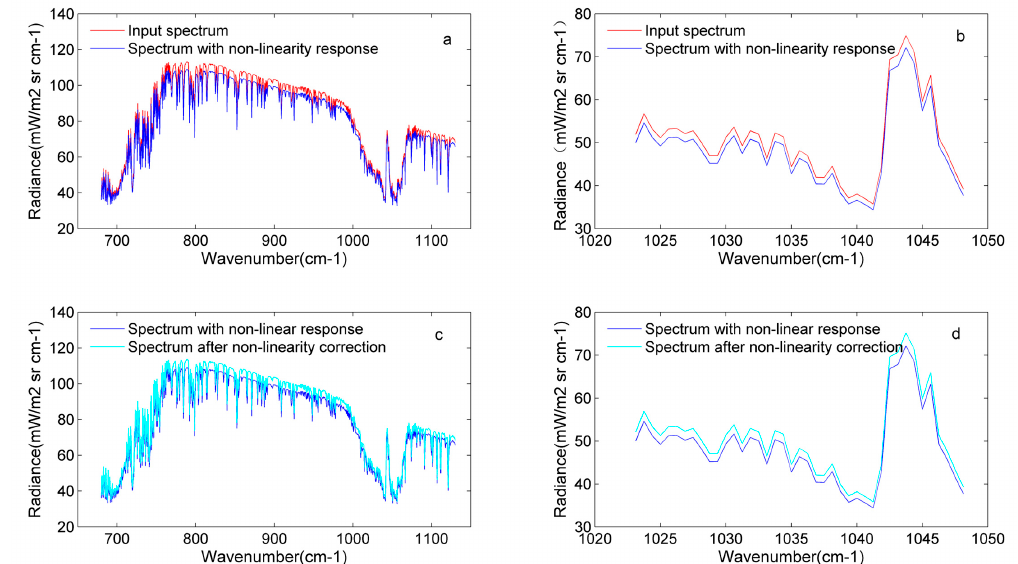
Figure 12. Analysis of the nonlinearity response for detector 81: ( a ) comparison between the input spectrum and the spectrum with a nonlinearity response from 680 to 1130 cm − 1 ; ( b ) comparison between the input spectrum and the spectrum with the nonlinearity response from 1023 to 1048 cm − 1 ; ( c ) comparison between the spectrum with the nonlinearity response and the spectrum after nonlinearity correction from 680 to 1130 cm − 1 ; ( d ) comparison between the spectrum with the nonlinearity response and the spectrum after nonlinearity correction from 1023 to 1048 cm − 1 .